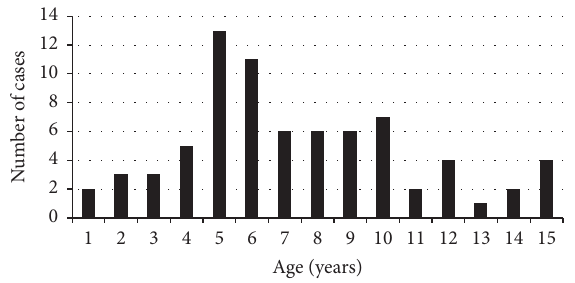
Figure 1: The breakdown of age in